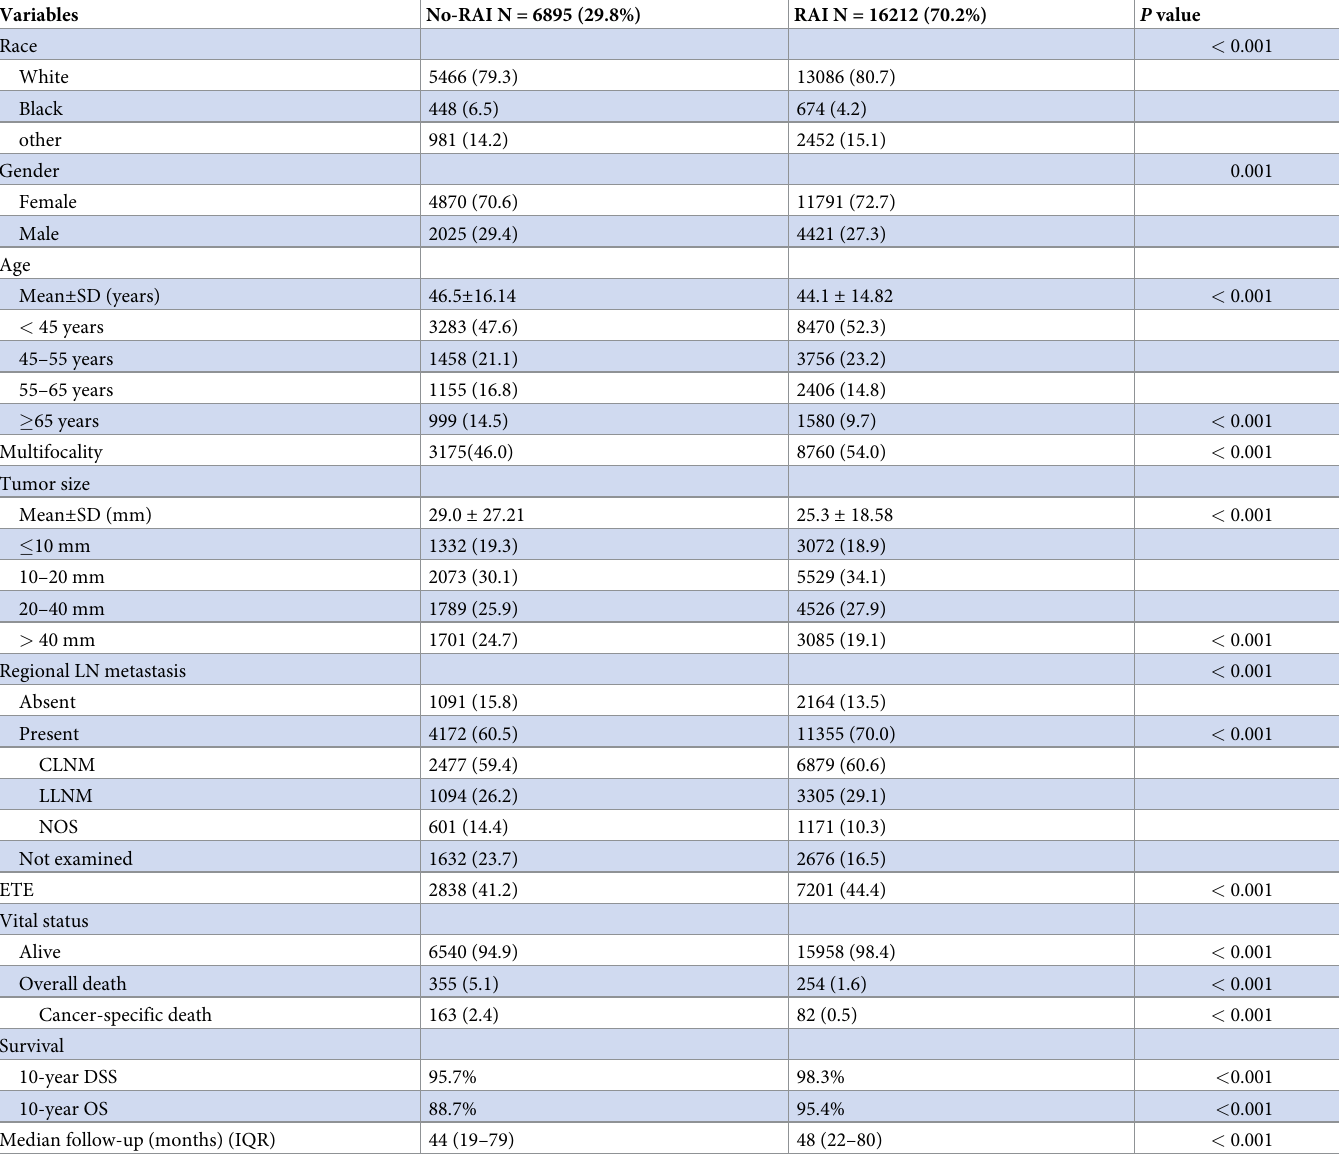
Table 1. Clinicopathological characteristics of intermediate risk PTC patients with or without RAI ablation. (N =